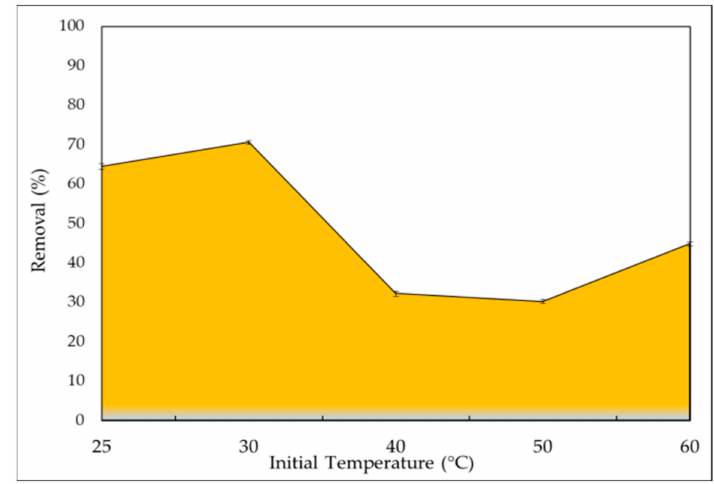
Figure 7. IV2R uptake capacities at varying temperature